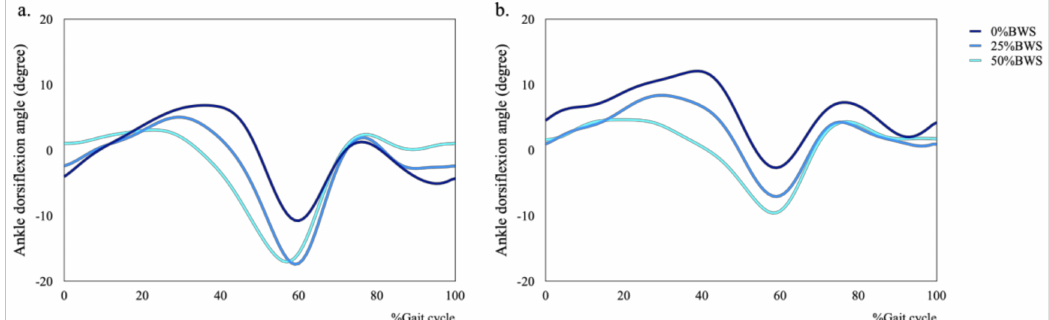
Figure 6. Mean plots of ankle dorsiflexion during walking under 0%, 25% and 50%BWS conditions (( a ) male, ( b ) female).